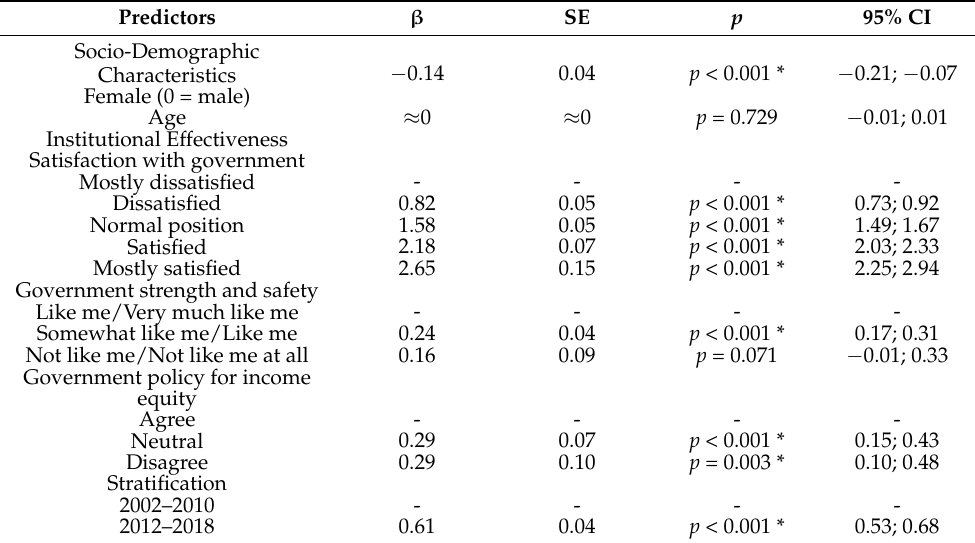
Table 2. Model 1—Political responsiveness adjusted for stratification